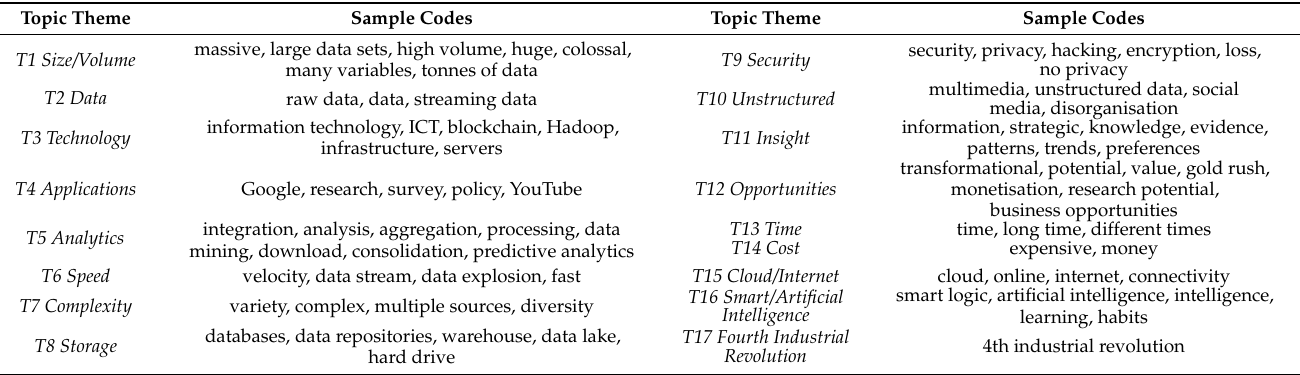
Table 2. Social Representations of Big